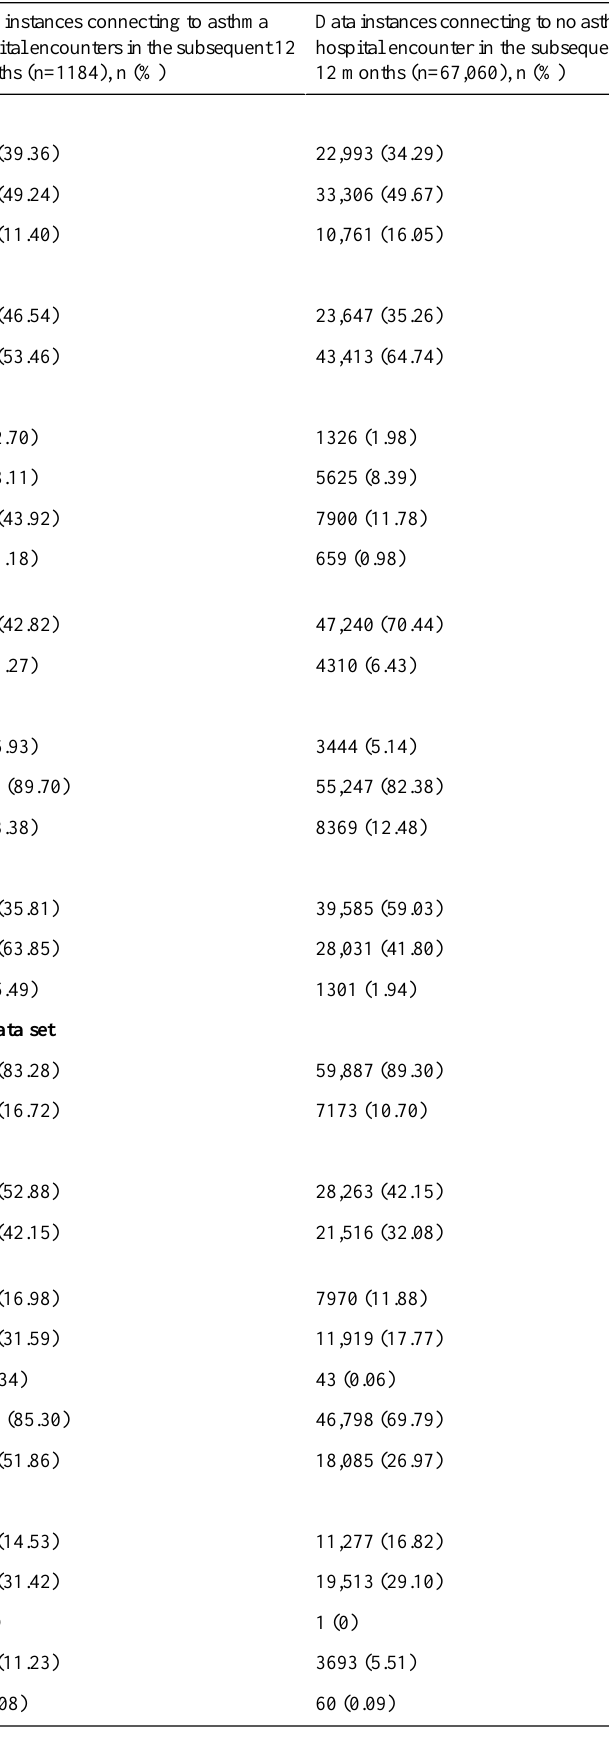
Table 2. Demographic and clinical characteristics of patients with asthma at the University of Washington Medicine during